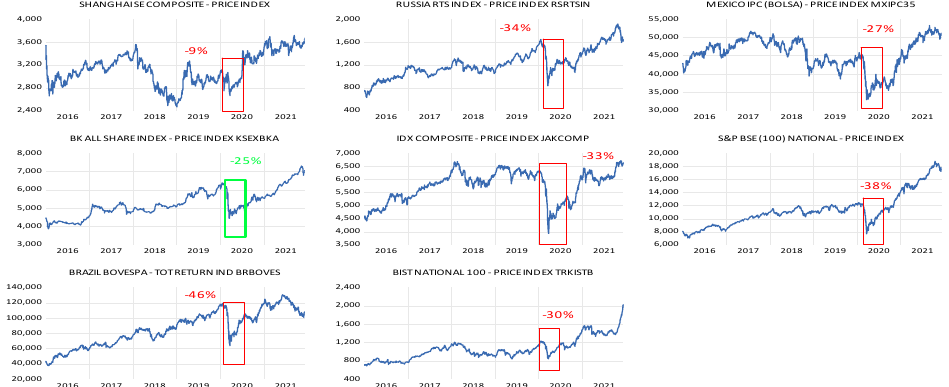
nected from worldwide panic tendencies. China’s reaction to the virus was focused on stabilising and controlling the spread of the virus and reacted more strongly to its effects than the rest of the world economies. In the context of the E7 stock markets, the Kuwaiti index performed relatively better, except for the case of the Chinese stock market, repre- sented by the Shanghai Composite Index (DataStream 2022).